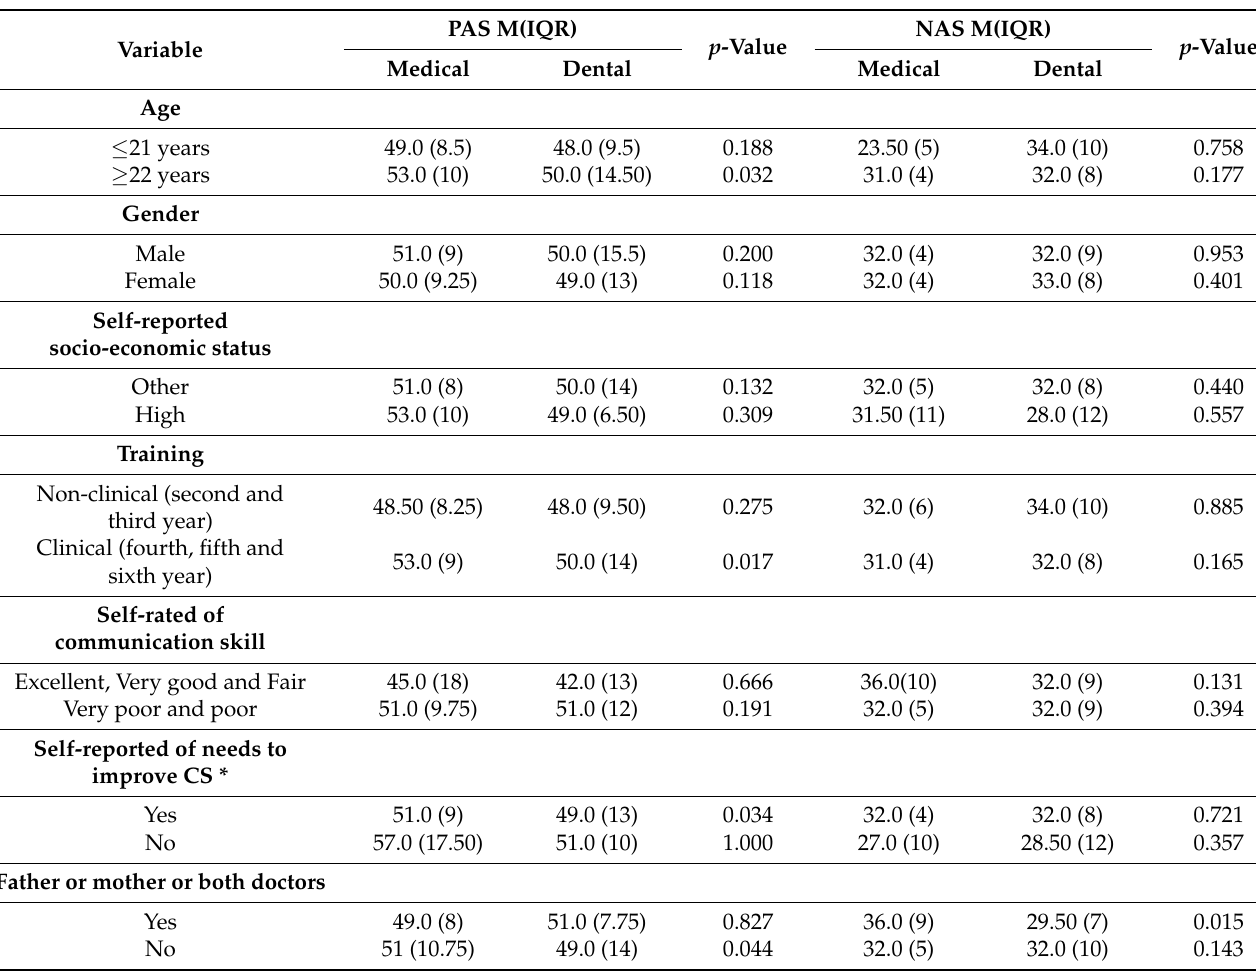
Table 2. Comparisons of medical and dental students’ attitudes towards CS skills ( n =